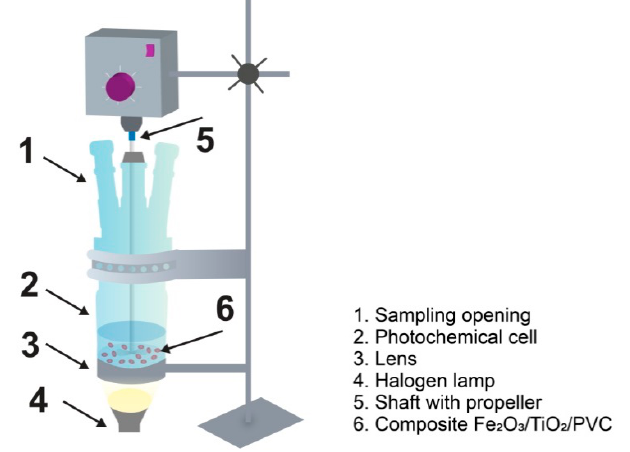
Figure 1. Schematic diagram of the photocatalytic reactor [25]. Reproduced with permission from [25]. Copyright Springer,